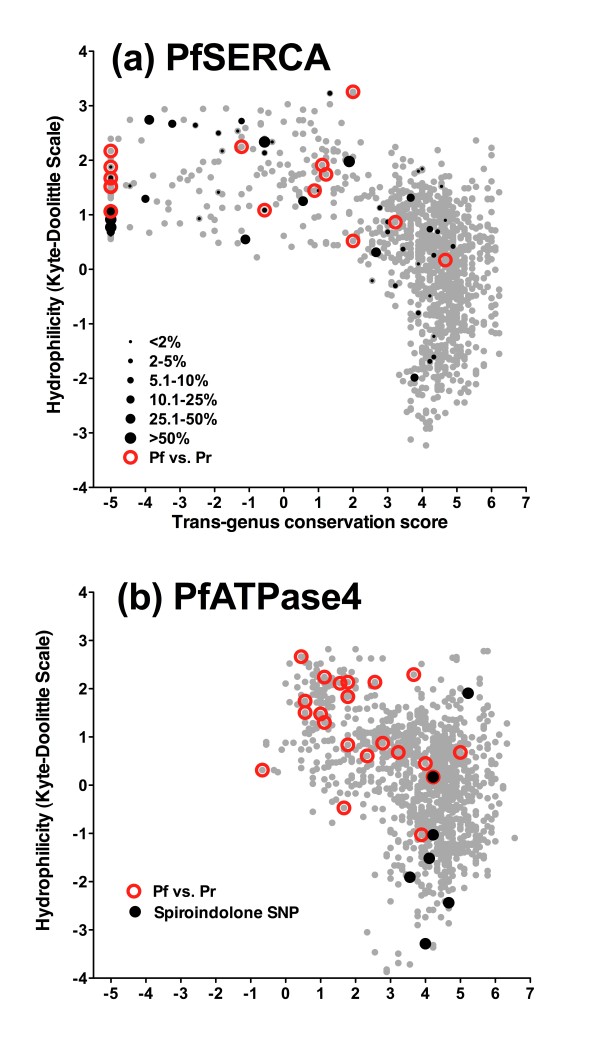
Conservation-hydrophilicity plots and single-nucleotide changes in the hominid malaria clade in calcium-ATPase genes. (a) PfSERCA (PFA0310c) showing amino acid variants between P. falciparum and P. reichenowi and field amino acid variants (see Table 3); symbol size indicates maximum allele frequency on a countrywide basis. (b) PfATPase4 (PFL0590c), showing amino acid variants between P. falciparum and P. reichenowi as well as the mutations associated with spiroindolone selection (see text). Conservation and hydrophilicity are derived as for Figure 3.